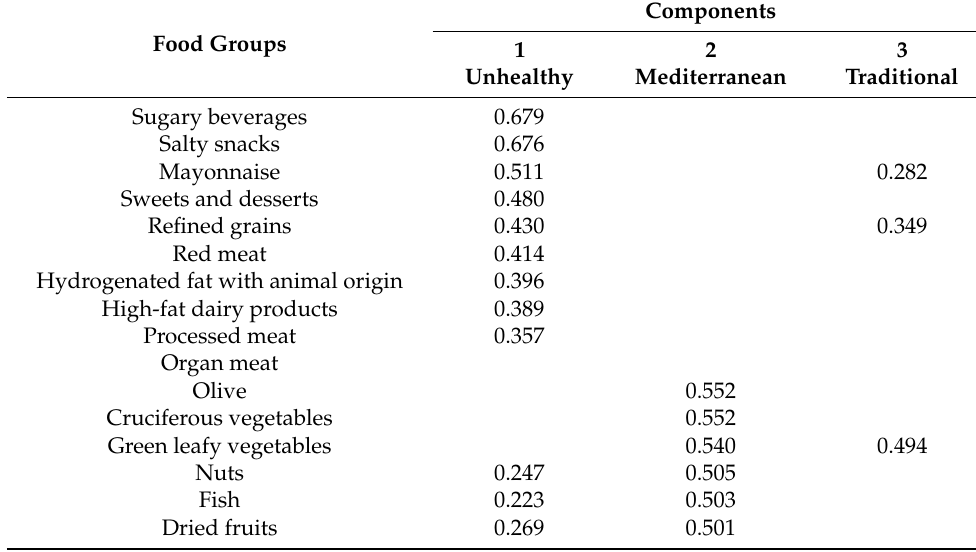
Table 3. Factor-loading rotated matrix and Eigenvectors for the three identified dietary